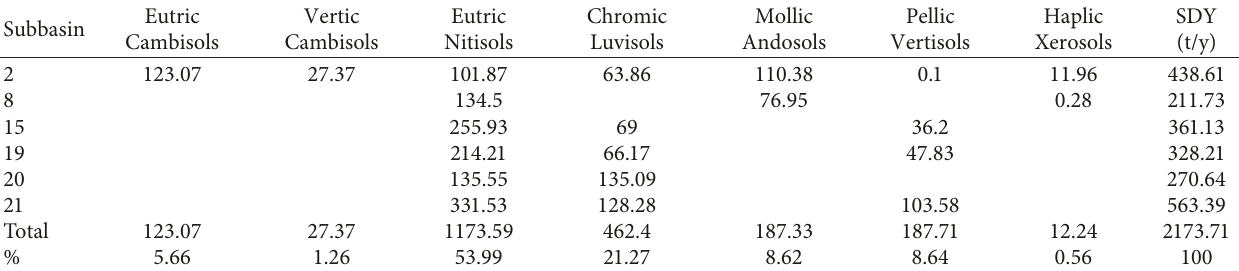
Table 10: Soil type and sediment